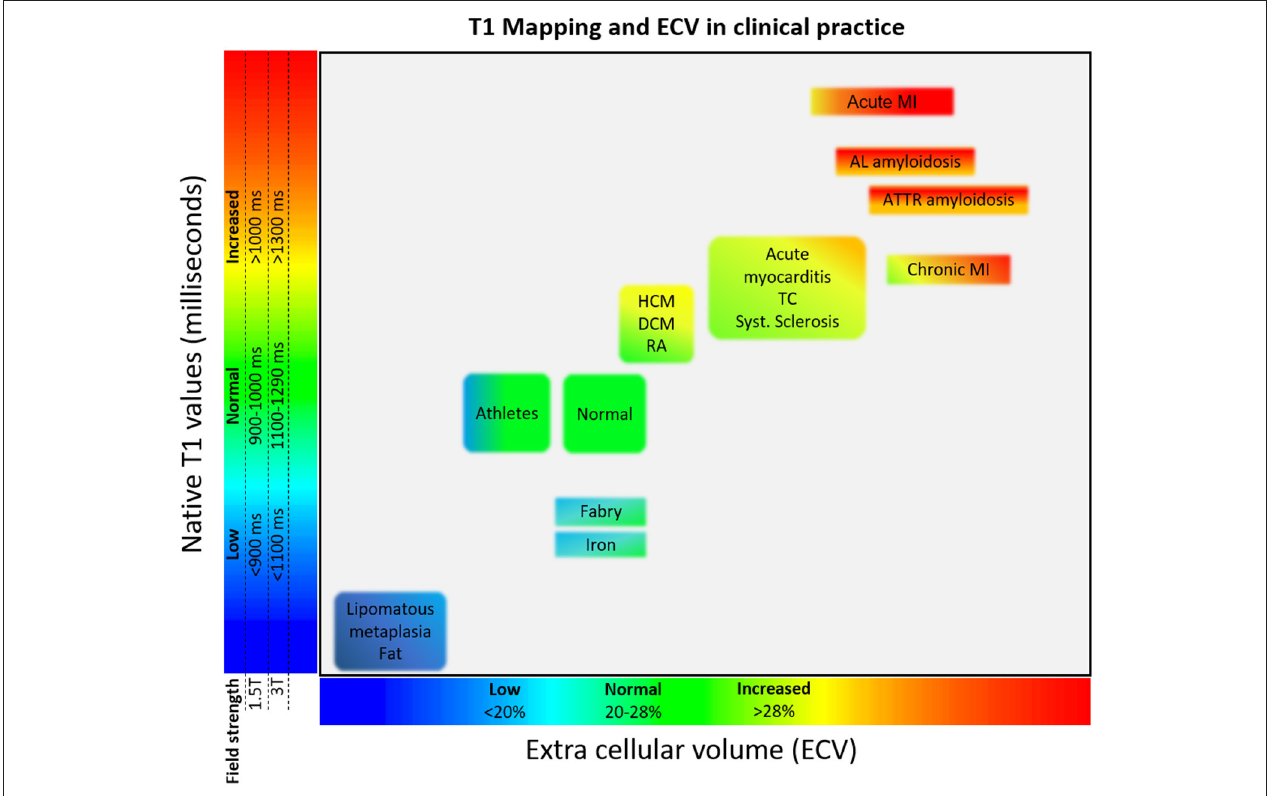
FIGURE 2 | Tissue characterisation using native T1 and ECV. Absolute values for native T1 depend greatly on field strength (1.5 or 3T), pulse sequence (MOLLI or ShMOLLI), scanner manufacturer and rules of measurements. For the purpose of comparability, only studies using MOLLI sequences were considered in this figure. AL, amyloid light chain; ATTR, amyloid transthyretin; DCM, dilated cardiomyopathy; ECV, extracellular volume; HCM, hypertrophic cardiomyopathy; MI, myocardial infarction; RA, rheumatoid arthritis; TC, takotsubo